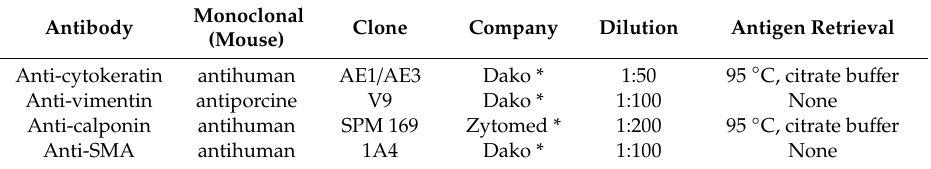
Table 1. Primary Antibodies Used for Immunostaining of 119 Pet Rabbit Mammary Carcinomas. Monoclonal Clone Company Dilution Antigen Retrieval Antibody (Mouse) Anti-cytokeratin antihuman AE1 / AE3 Dako * 1:50 95 ◦ C, citrate bu ff er Anti-vimentin antiporcine V9 Dako * 1:100 None Anti-calponin antihuman SPM 169 Zytomed *